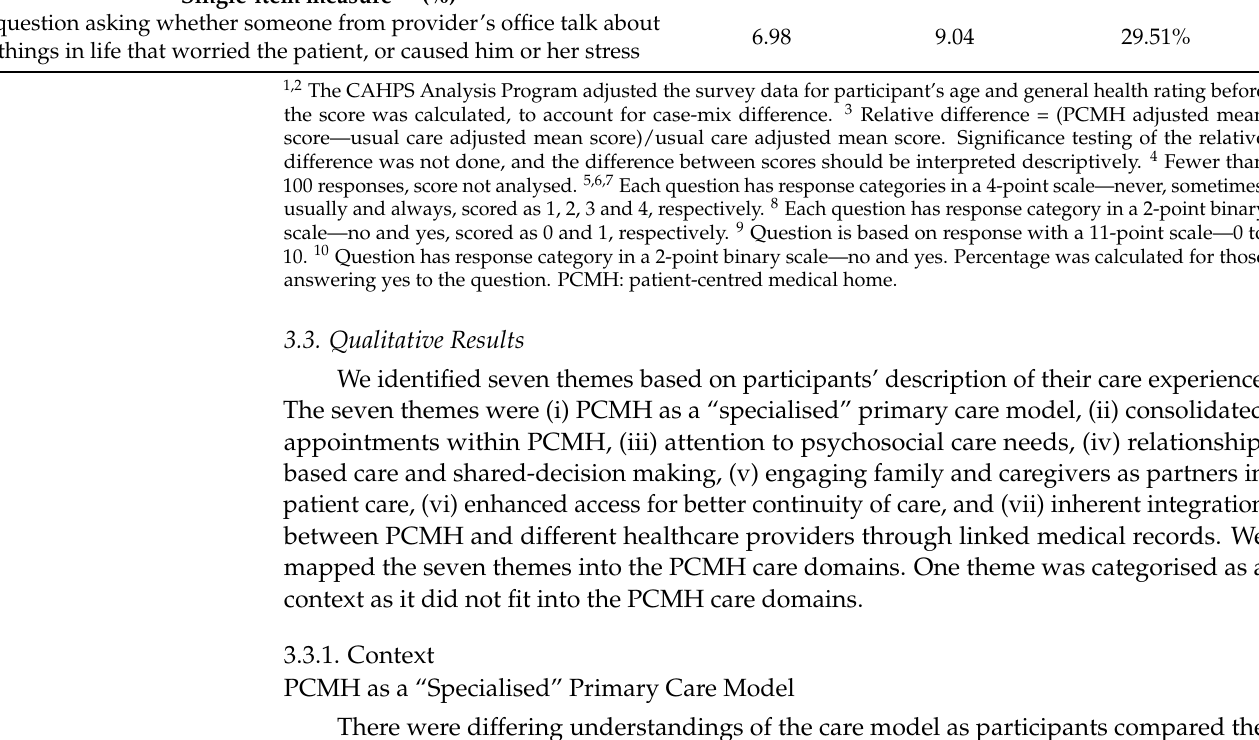
Percentage PCMH Usual Care Difference (N = 166), (N = 184), Relative to Usual Adjusted Adjusted Care Mean Score 2 Mean Score 1